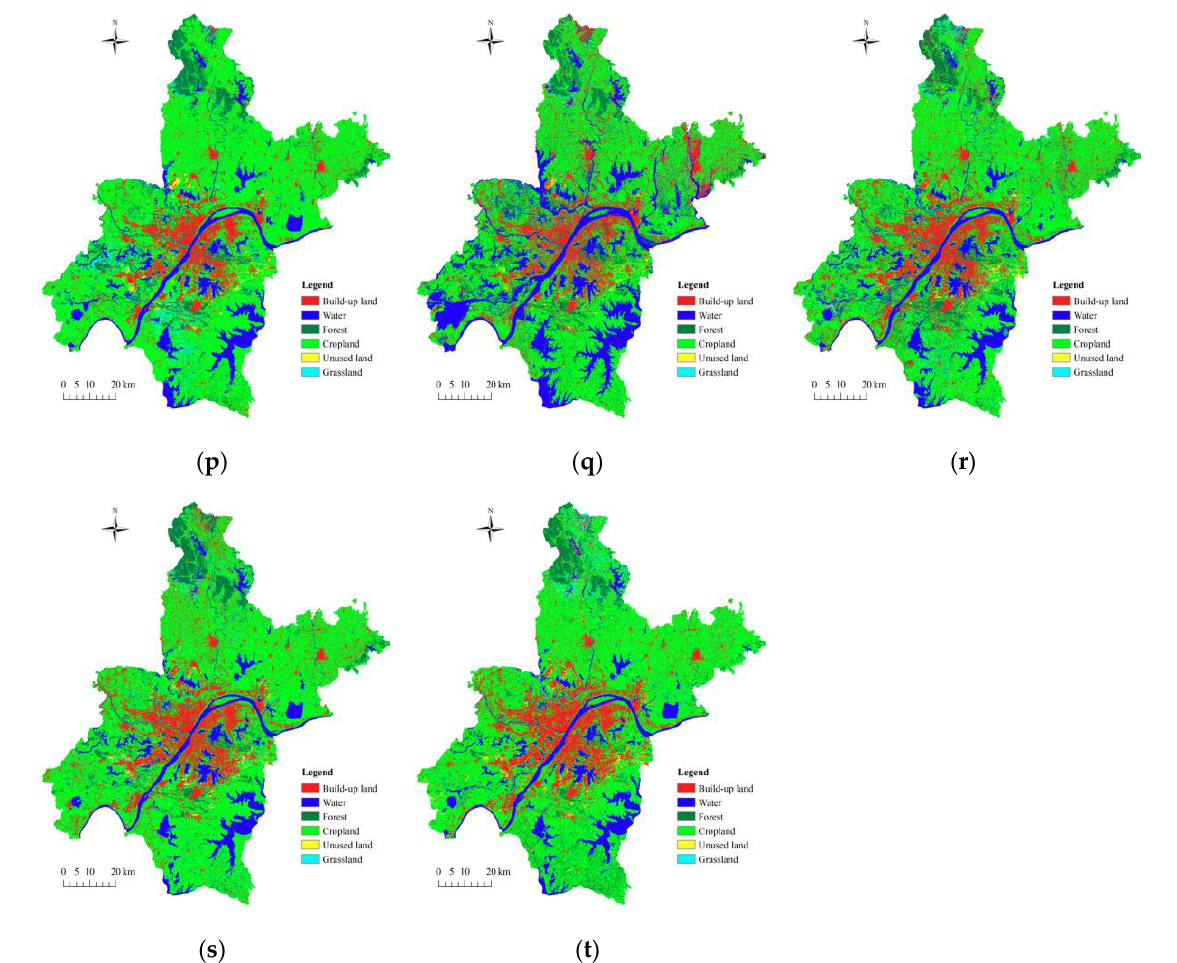
Figure 4. The LULC map of Wuhan for each year during the period 2000 – 2019: the LULC map in ( a ) 2000; ( b ) 2001; ( c ) 2002; ( d ) 2003; ( e ) 2004; ( f ) 2005; ( g ) 2006; ( h ) 2007; ( i ) 2008; ( j ) 2009; ( k ) 2010; ( l ) 2011; ( m ) 2012; ( n ) 2013; ( o ) 2014; ( p ) 2015; ( q ) 2016; ( r ) 2017; ( s ) 2018; and ( t ) 2019. Table 3. Accuracy assessment of the LULC maps of Wuhan during the period 2000 – 2019.